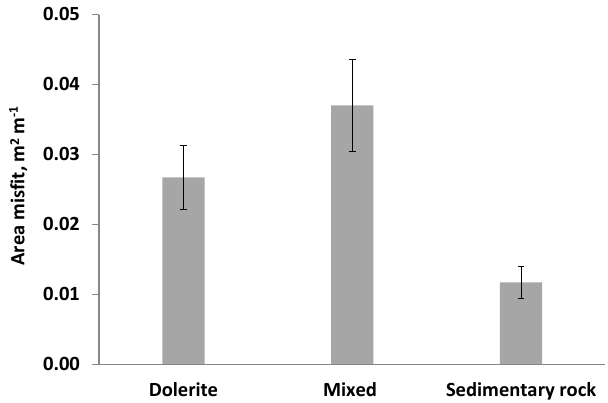
Figure 7. Relationship between area misfit and borehole sub- surface lithology. Error bars represent standard errors, with a 1 σ confidence interval.